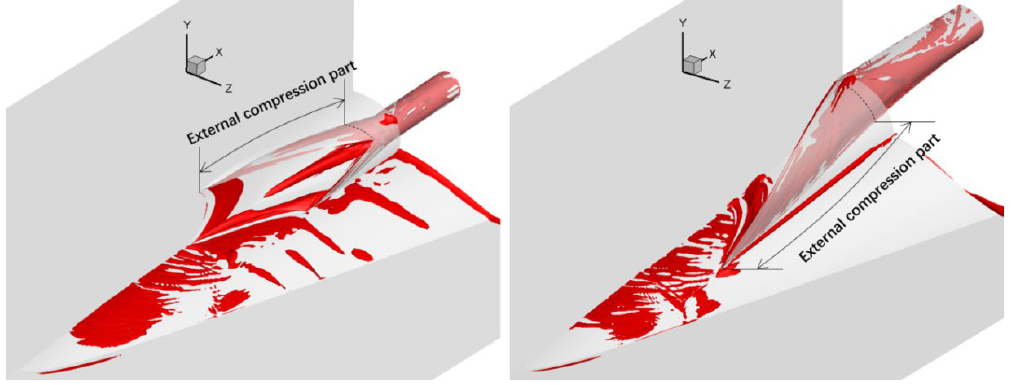
Figure 9. Vortex structures under design conditions based on the Q-criteria (Q = 7 × 10 6 ). Table 4. Aerodynamic characteristics under a wide range of inflow speed